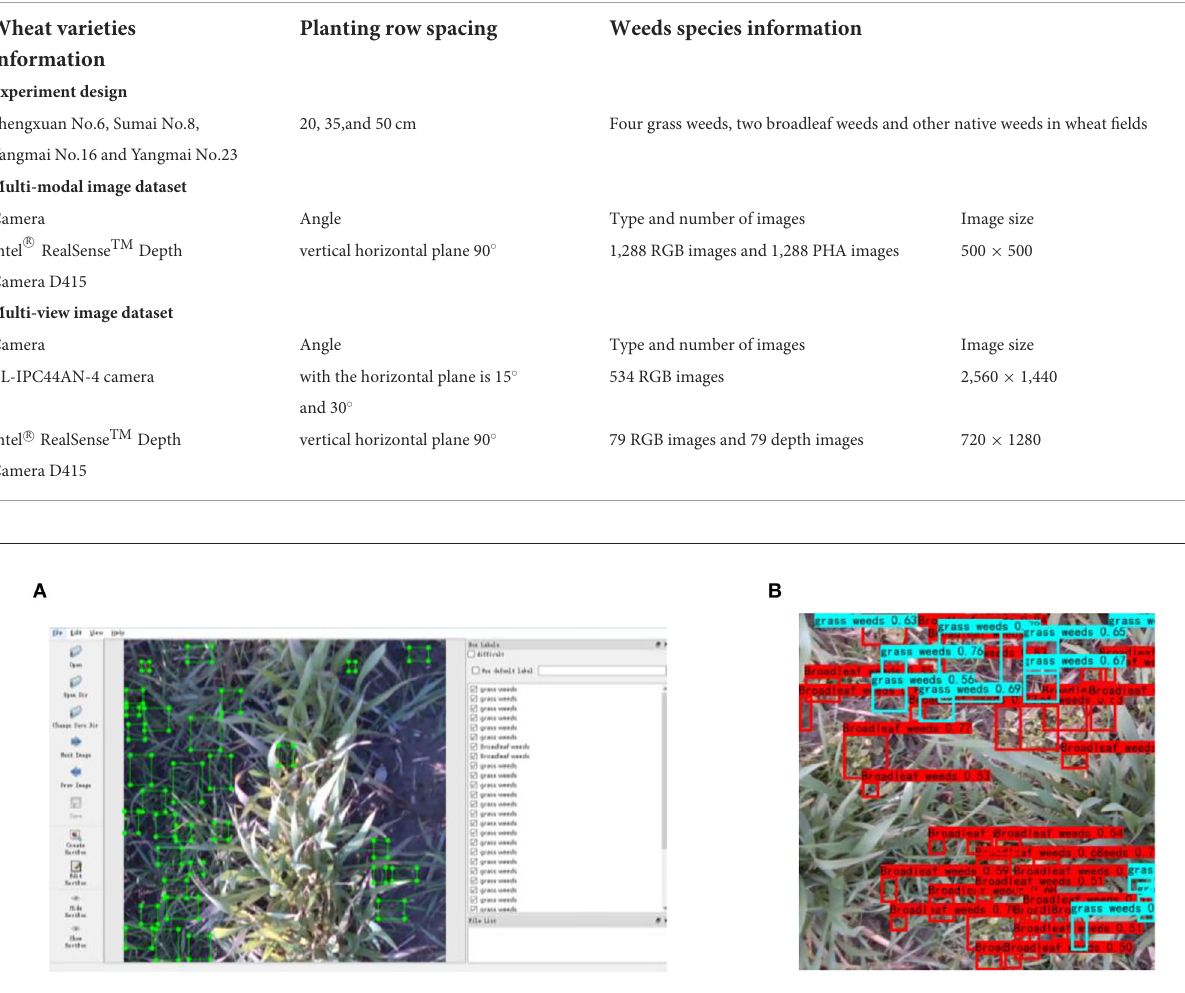
FIGURE2 (A) Labeling of grass and broadleaf weeds in wheat fields using LabelImg and (B) weed detection result in wheat field.